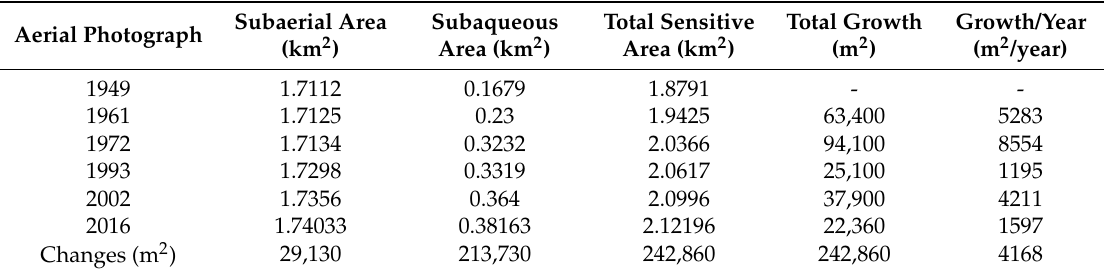
Table 1. Area analyses of the Wandandian Delta for the overall delta growth, subaqueous area, total sensitive area, and average deltaic progradation * .